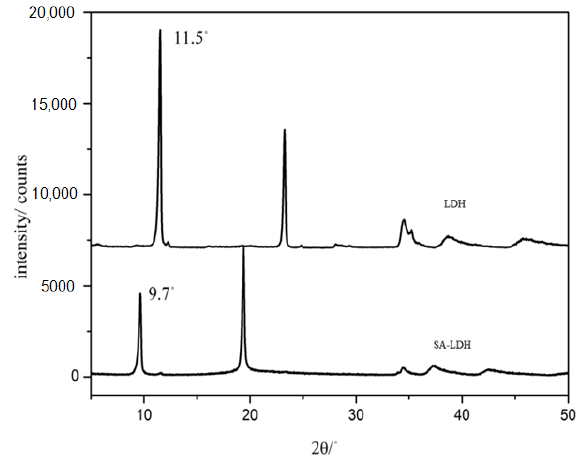
Figure 2. XRD patterns of LDH and SA-LDH.